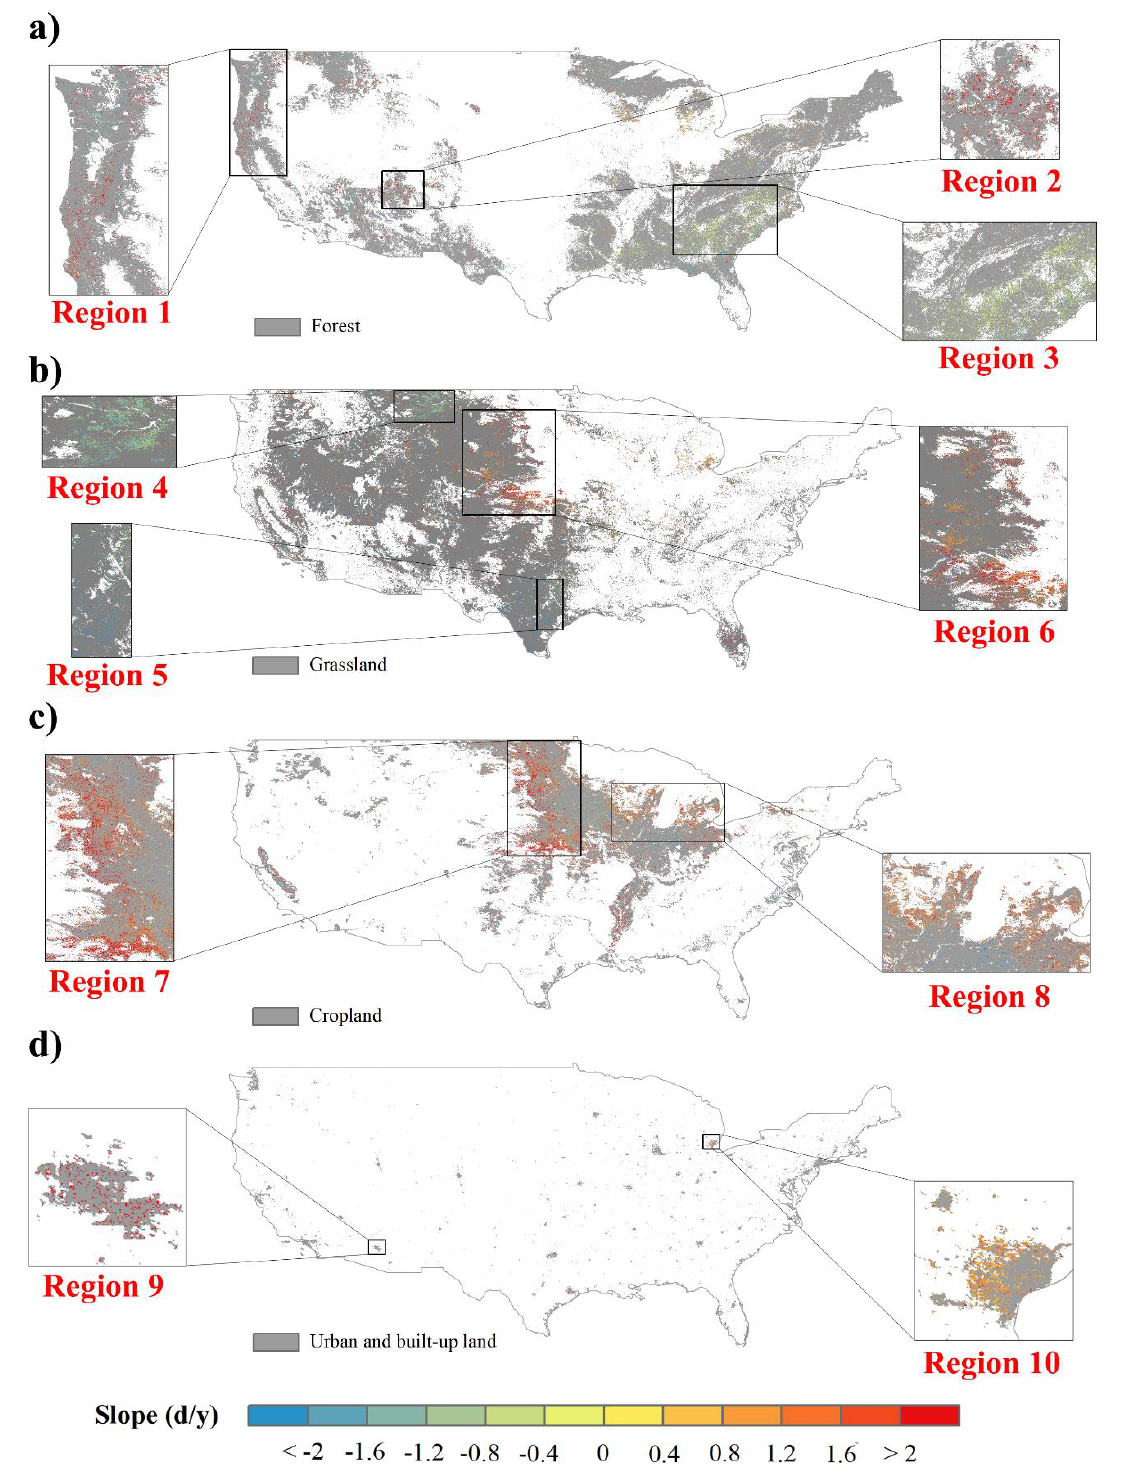
Figure 9. Trends distribution of SOS in four land cover types from 2001 to 2021, where a ) is forest, ( b ) is grassland, ( c ) is cropland, and ( d ) is urban and built-up b ) is grassland, c ) is cropland, and d ) is urban and built-up land.